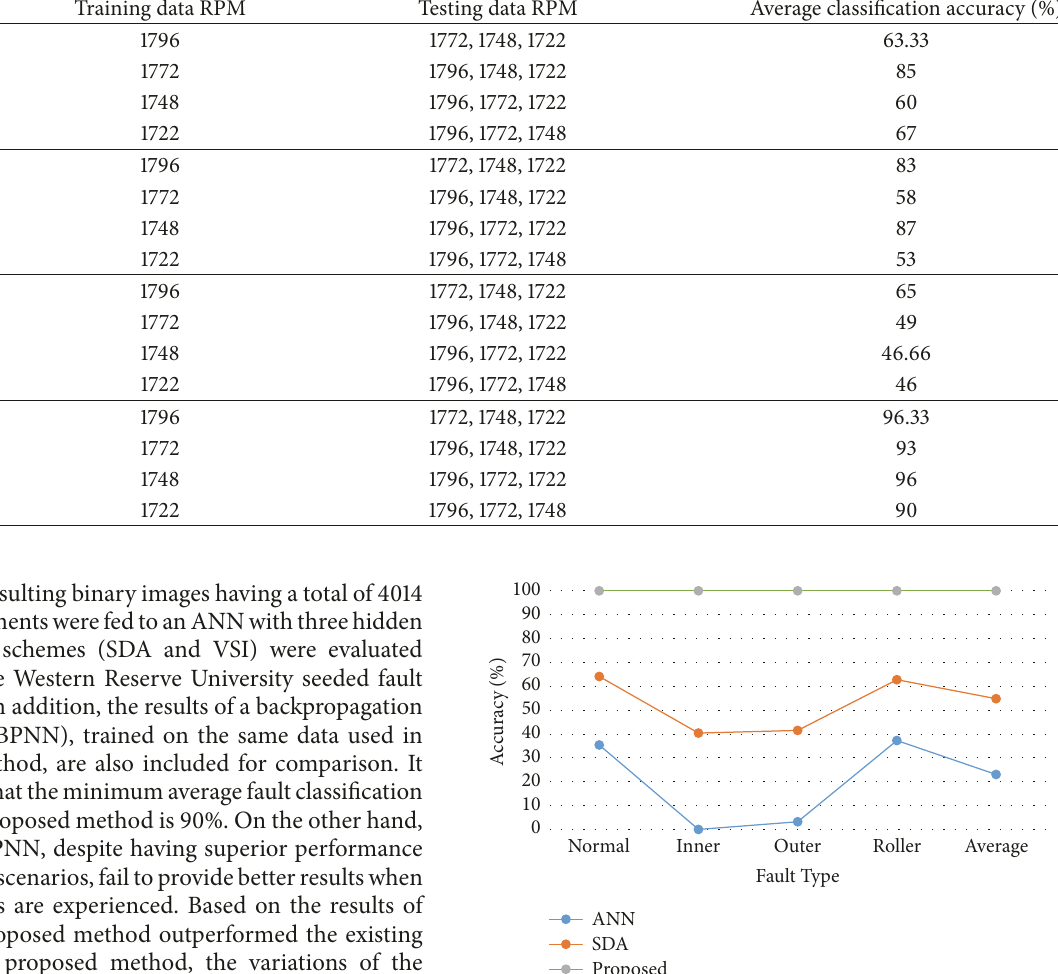
Table 5: The average classification accuracy of the proposed method, BPNN, VSI, and SDA for variable shaft speed conditions. Method